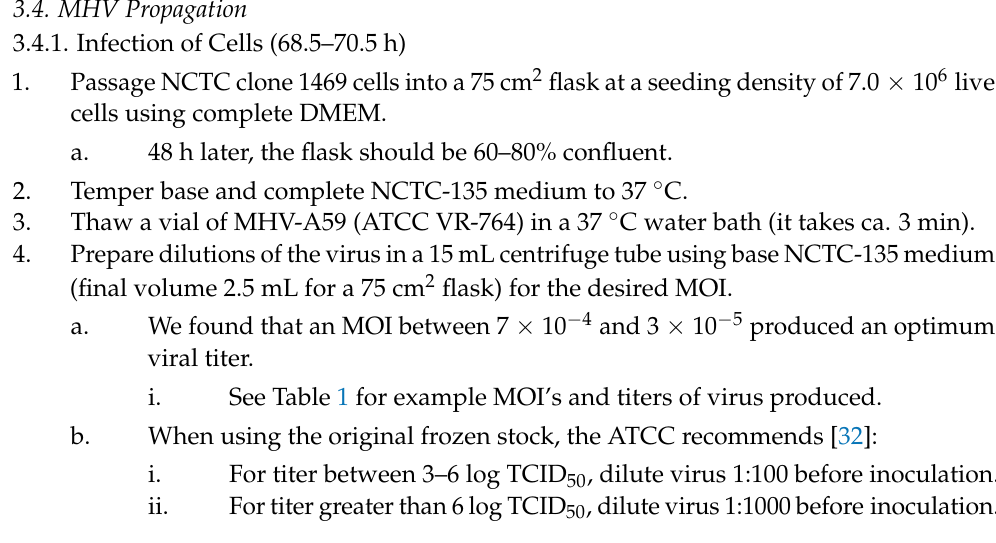
Table 1. Tested MOIs and resulting MHV titer after harvest across two